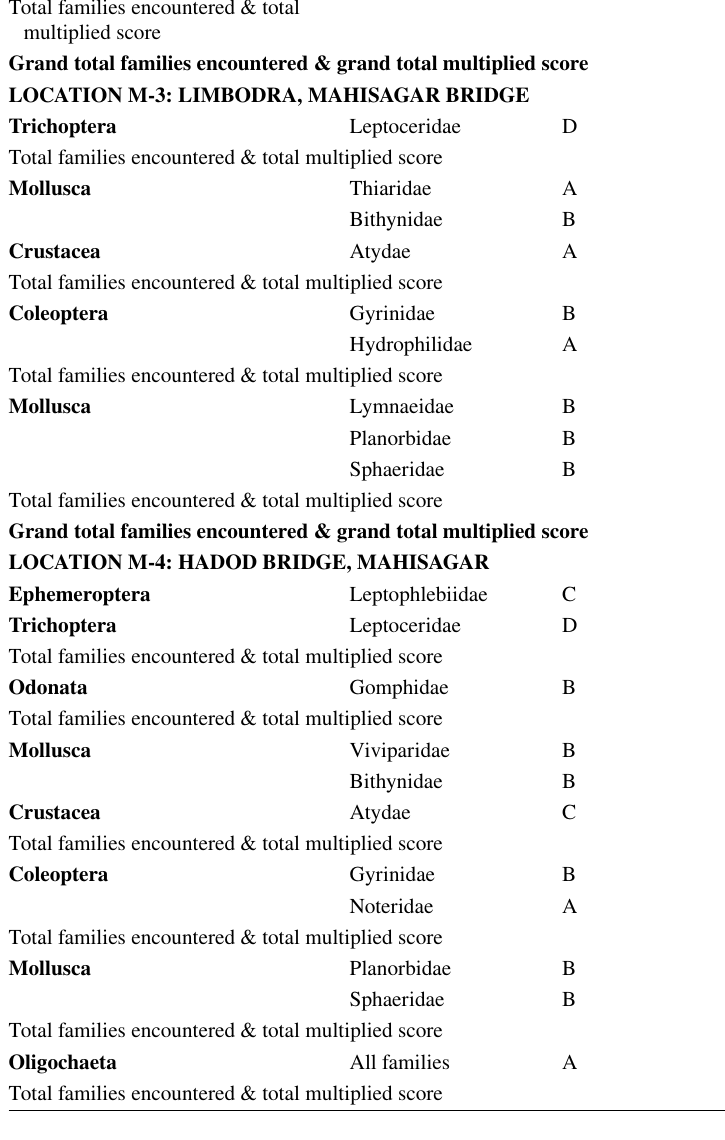
Total families BMWP Score Multi- possible species within families also mark abundancy AS - A, B, C, D, E